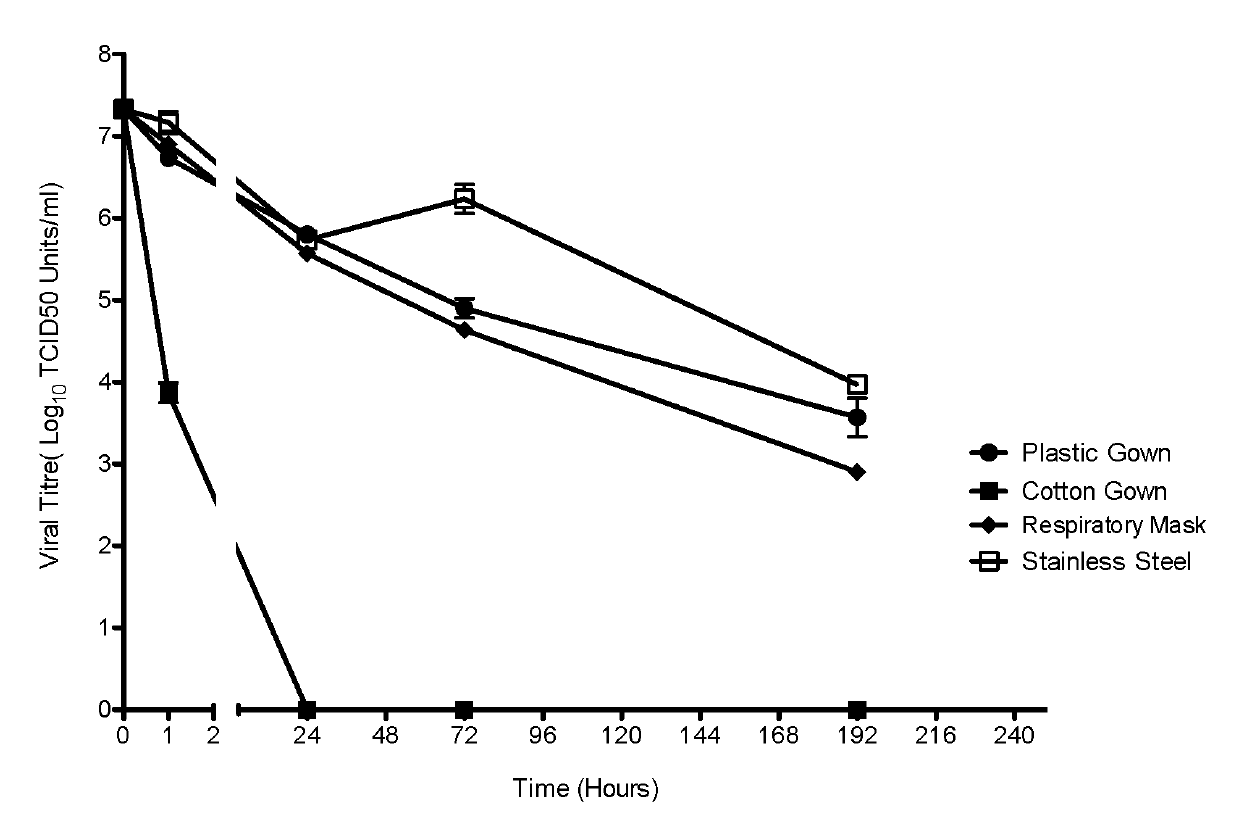
Figure 1. Environmental persistence of EBOV Makona (EBOV/Mak) suspended in an organic soil load. The robustness of high titre EBOV/Mak inoculums in an organic soil load was tested on 4 surfaces commonly used in health care environments at 21.5 °C and 30% relative humidity. Viral titres were measured per environmental carrier by the TCID 50 assay. The error bars represent the standard error of the mean. Three technical repetitions were performed for each surface at every time point (n =